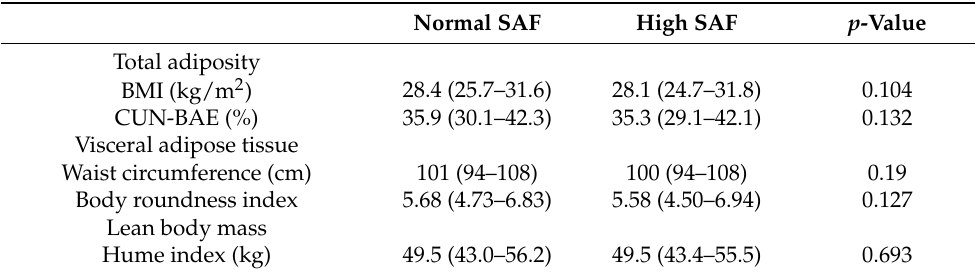
Table 2. Data of the anthropometric indices in all individuals according to skin autofluorescence values.